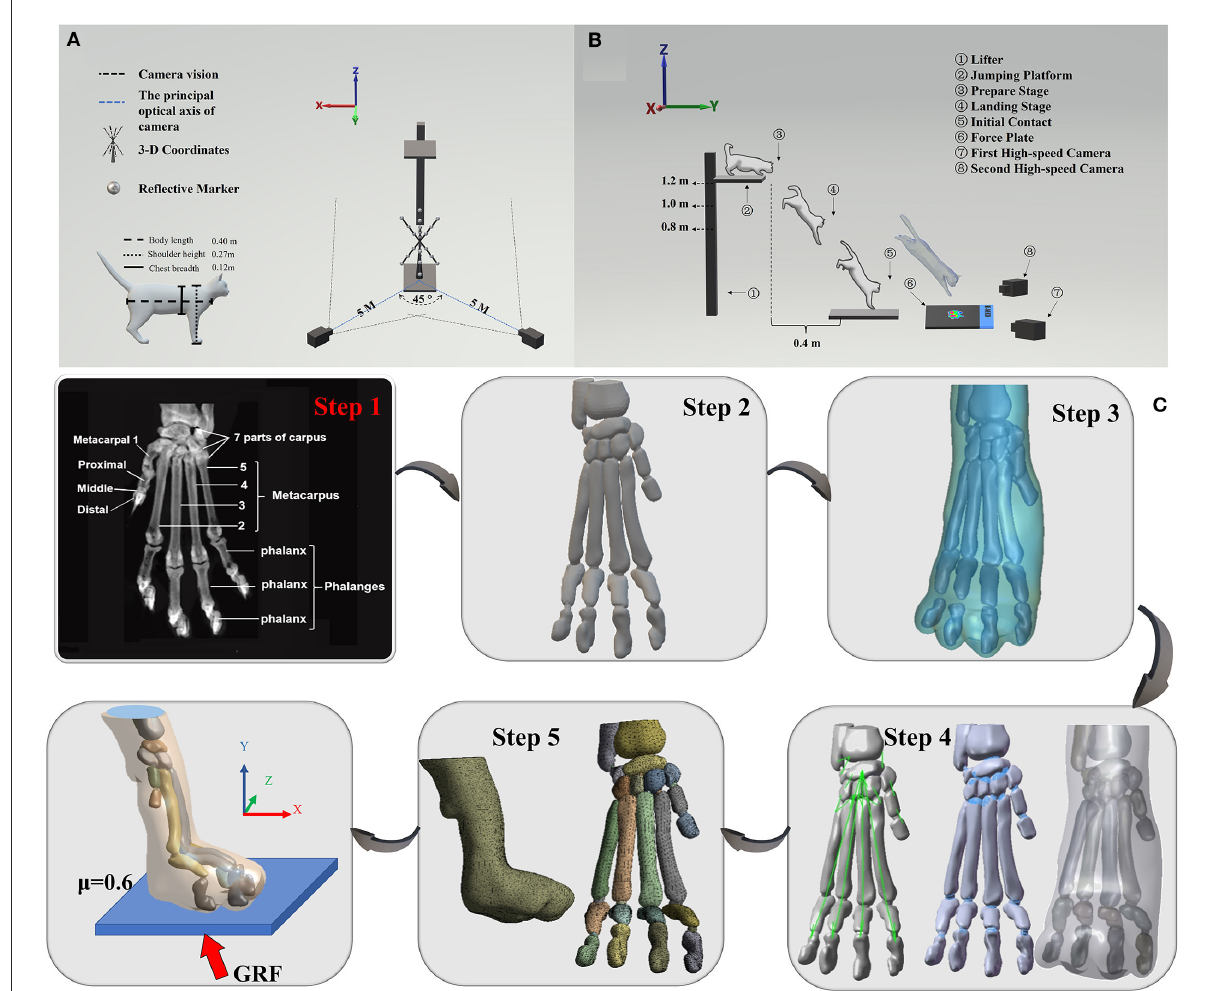
FIGURE1 (A) Illustration of the position of 3-D coordinates and two high-speed cameras. (B) Illustration of cat landing experimental procedure from the ready position of jumping platform to initial forelimbs contacting the force plate. (C) Illustration of the process of FEA. Step 1 is to obtain the coronal CT images of the right forelimb paw. Step 2 is the 3D model obtained by processing CT images through Mimics software, and then importing the 3D model into Geomagic software (Step 3) for post-processing such as noise reduction, spike removal and smoothing. After that, Step 4 was performed by using SolidWorks software to get cartilage, ligaments, and soft tissue (from left to right). Finally, Step 5 was executed by using ANSYS Workbench software to grid processing, then load and boundary conditions were applied to execute